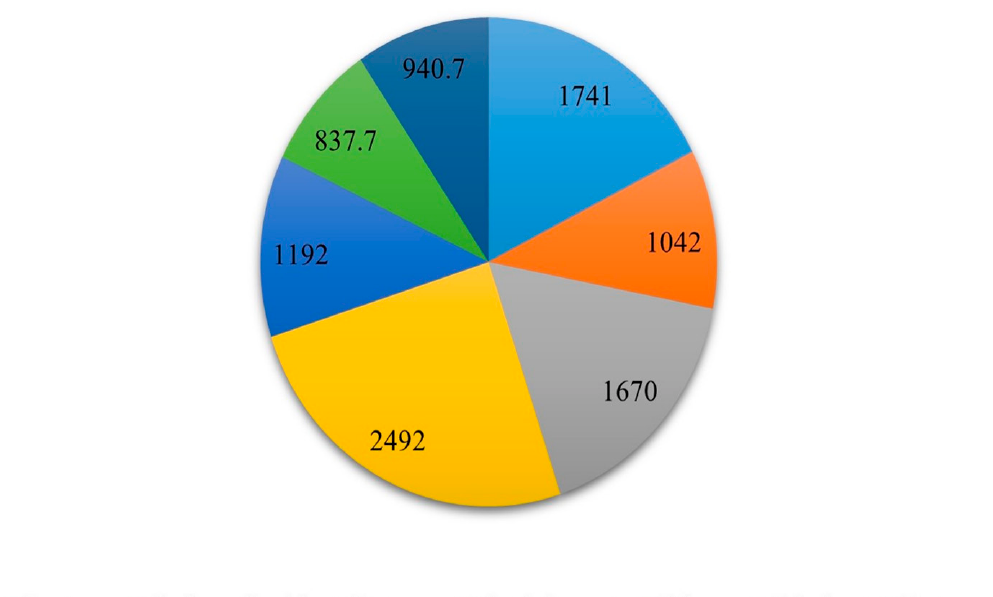
Figure 4. Demonstration of the total electricity generated by the ORC placing the working fluid in single mode.